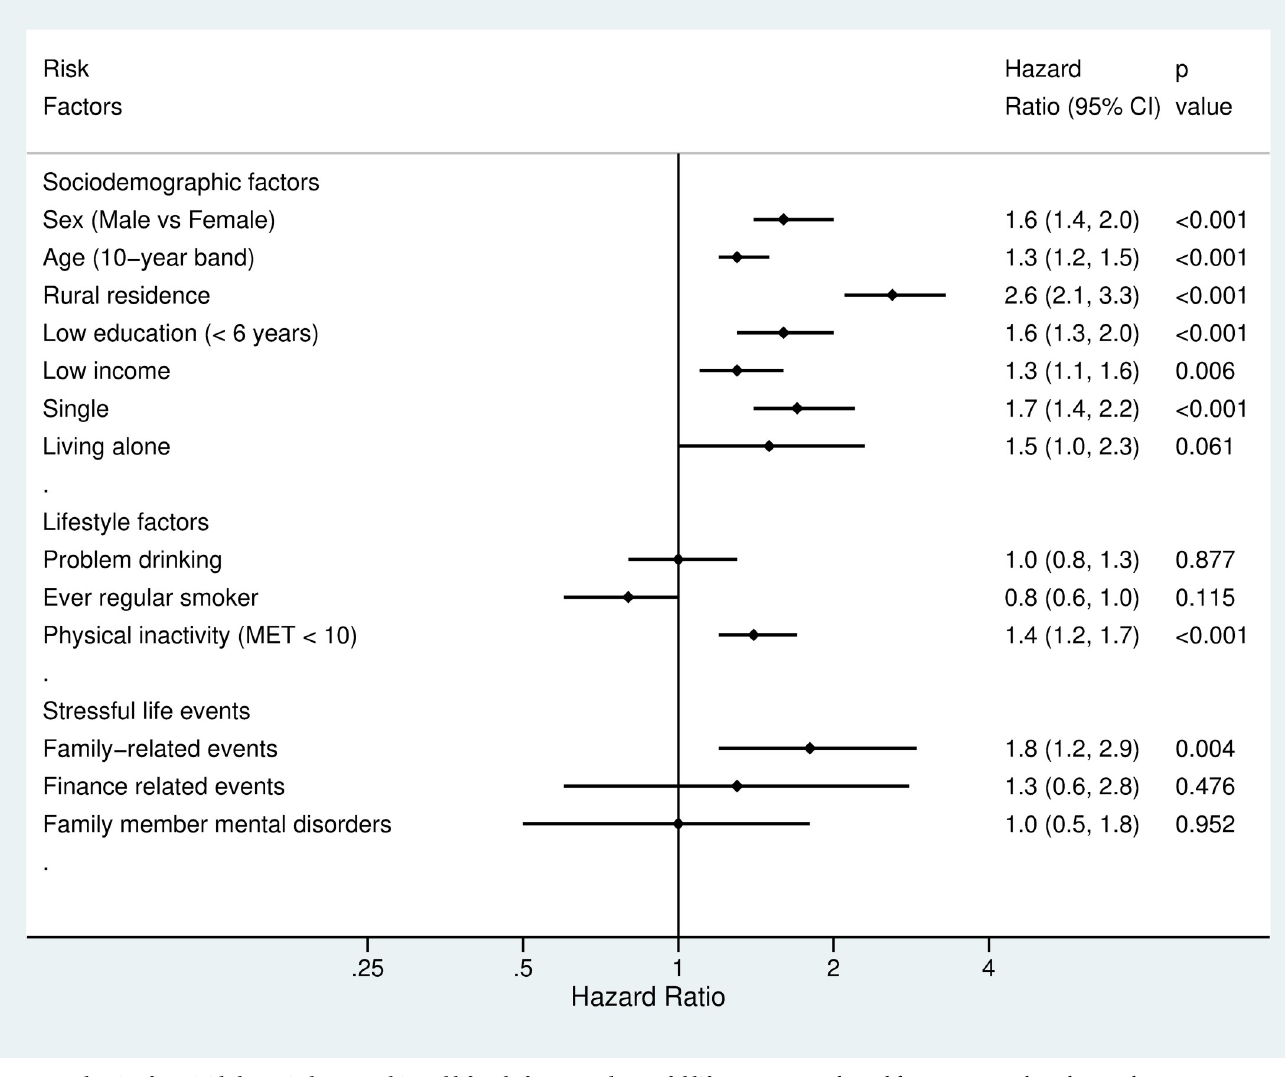
Fig 2. Hazard ratios for suicide by sociodemographic and lifestyle factors and stressful life events. HRs adjusted for sex, age, rural residence, education, income, and single status. HR, hazard ratio; MET, Metabolic Equivalent